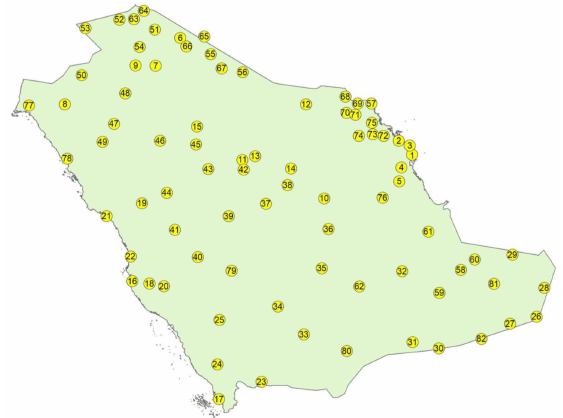
Figure 1. Distribution of the 82 selected sites in Saudi Arabia. The numbers in the circles refer to those in column 1 of Table 1. This figure is reproduction of Figure 1 in